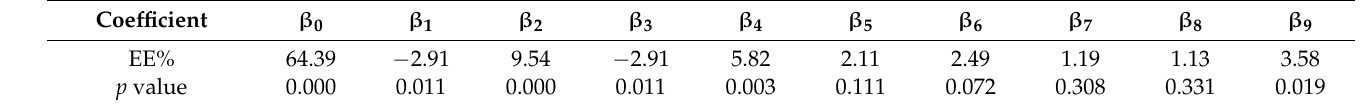
Table 11. Summary of regression coefficient analysis for the response Y3 (EE%).